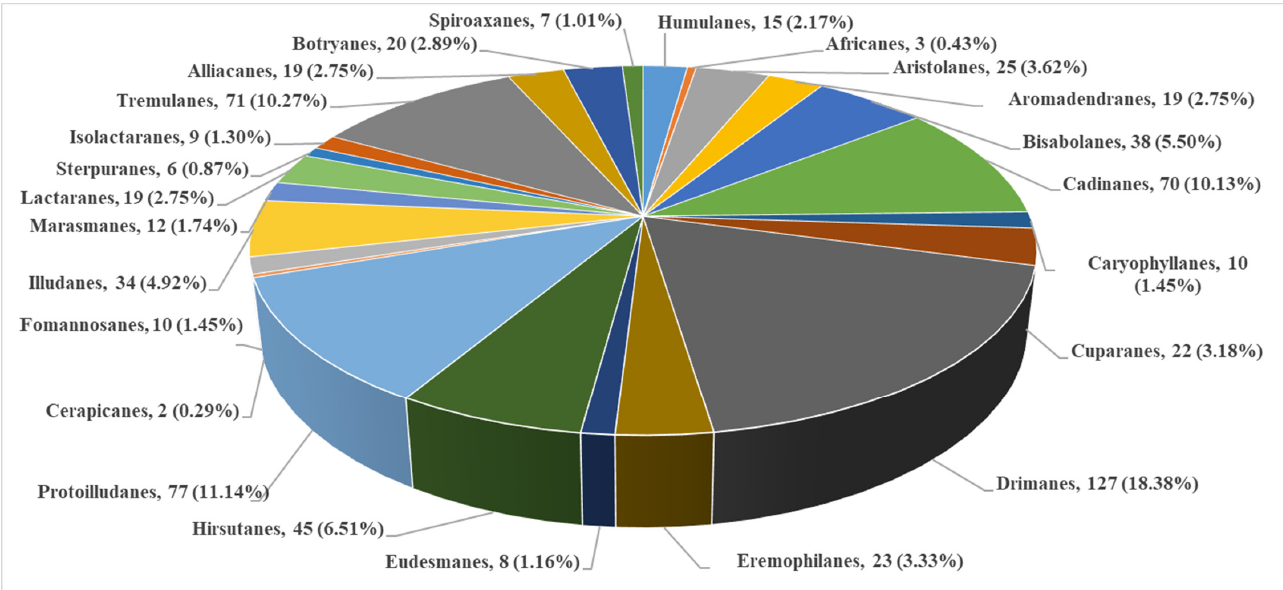
Figure 1. Basidiomycota sesquiterpenes classified by a